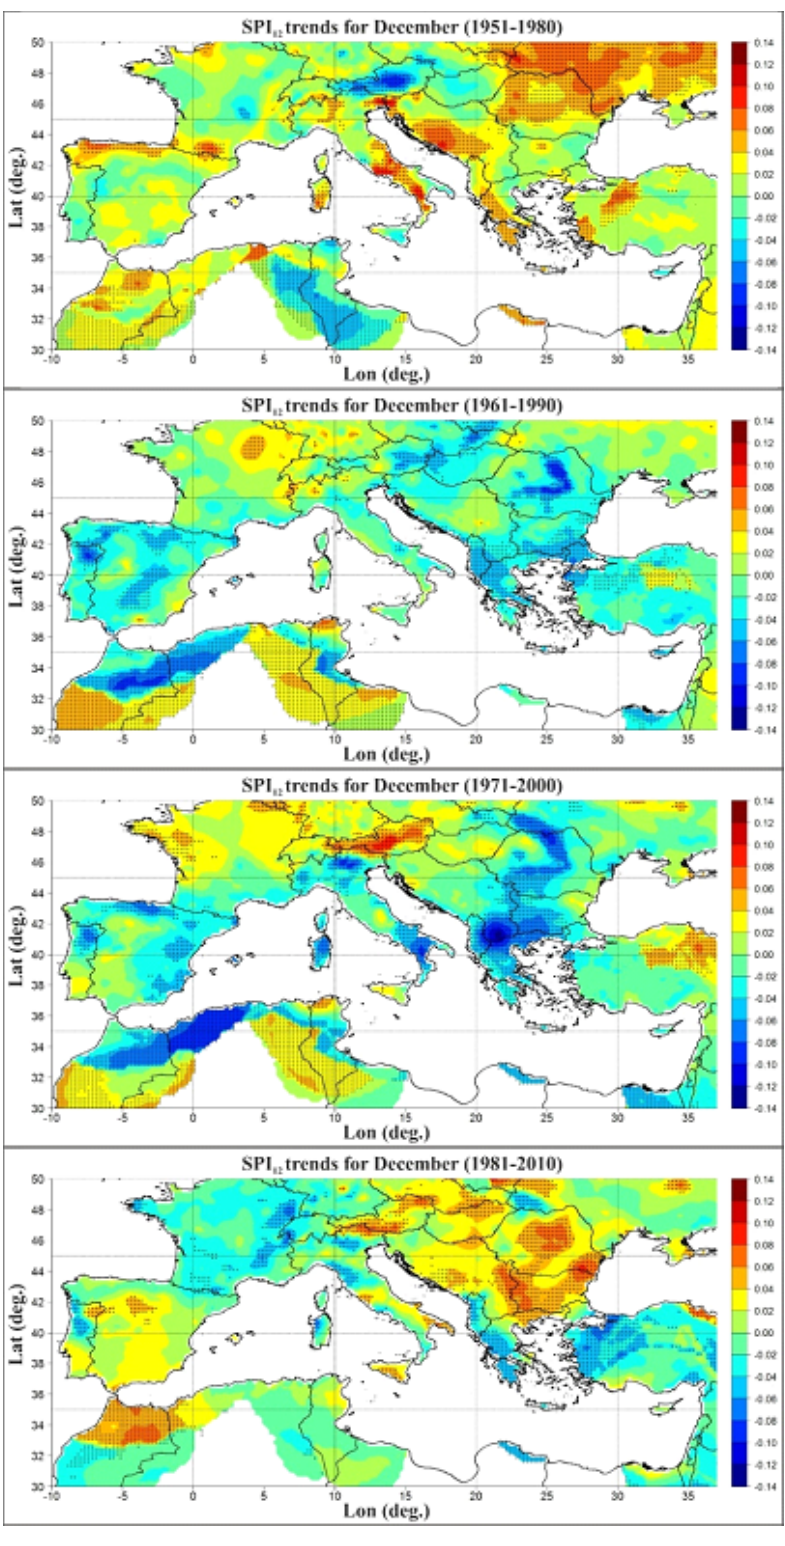
Figure 10. Evolution of December SPI12 trends over consecutive 30-year periods (annual; January to December). The values with an asterisk ( ∗ ) refer to statistically significant trends at 95% CL (adapted from Polychroni and Nastos,